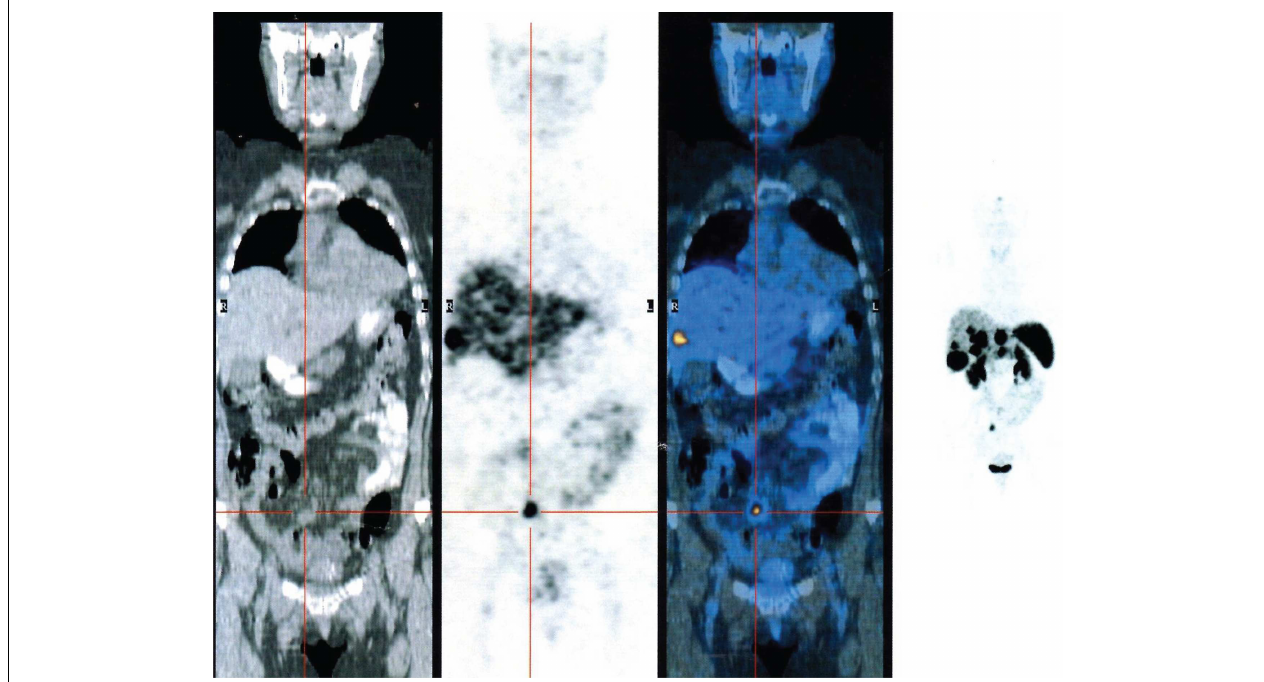
FIGURE 2 | PET gallium 68 DOTATOC showing the presence of multiple liver metastasis from neuroendocrine ileal tumor .